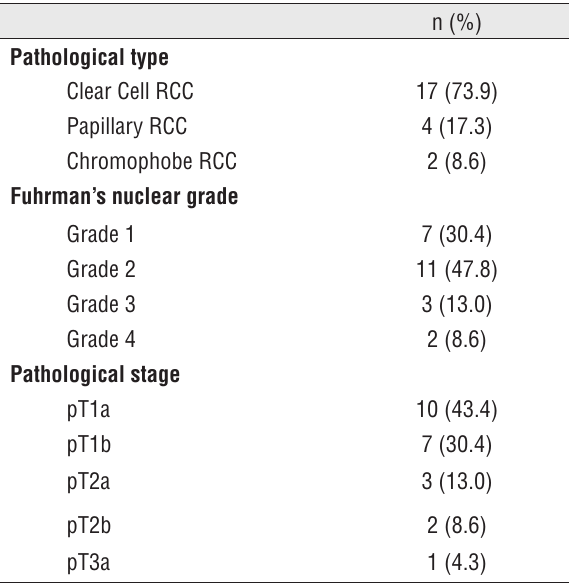
Table 1 - The pathological distribution of the tumors in patients.